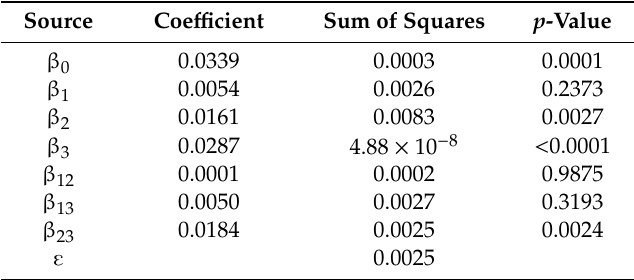
Table 4. Regression coefficients and probability p -values for thickness response.